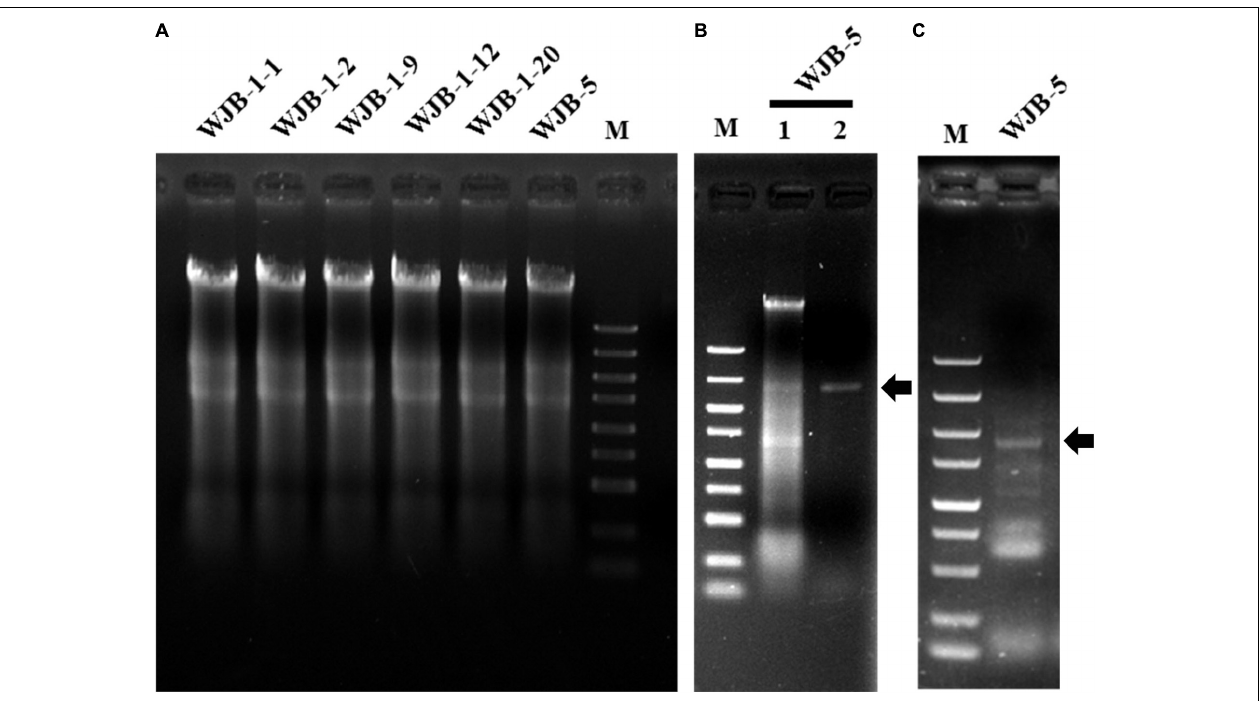
FIGURE 1 | Agarose gel electrophoresis of nucleic acids extracted from Melanconiella theae strains, enzyme digest and RT-PCR identification of MtMV1. (A) Nucleic acids extracted from strains WJB-1-1, WJB-1-2, WJB-1-9, WJB-1-12, WJB-1-20, and WJB-5. (B) The nucleic acids extracted from strain WJB-5 were untreated (Lane 1) or treated with S1 nuclease (Lane 2). (C) RT-PCR identification of MtMV1 in strain WJB-5. M: DL5000 DNA marker (100; 250; 500; 750; 1,000; 1,500; 2,000; 3,000; and 5,000 bp). The arrows indicate the target bands.